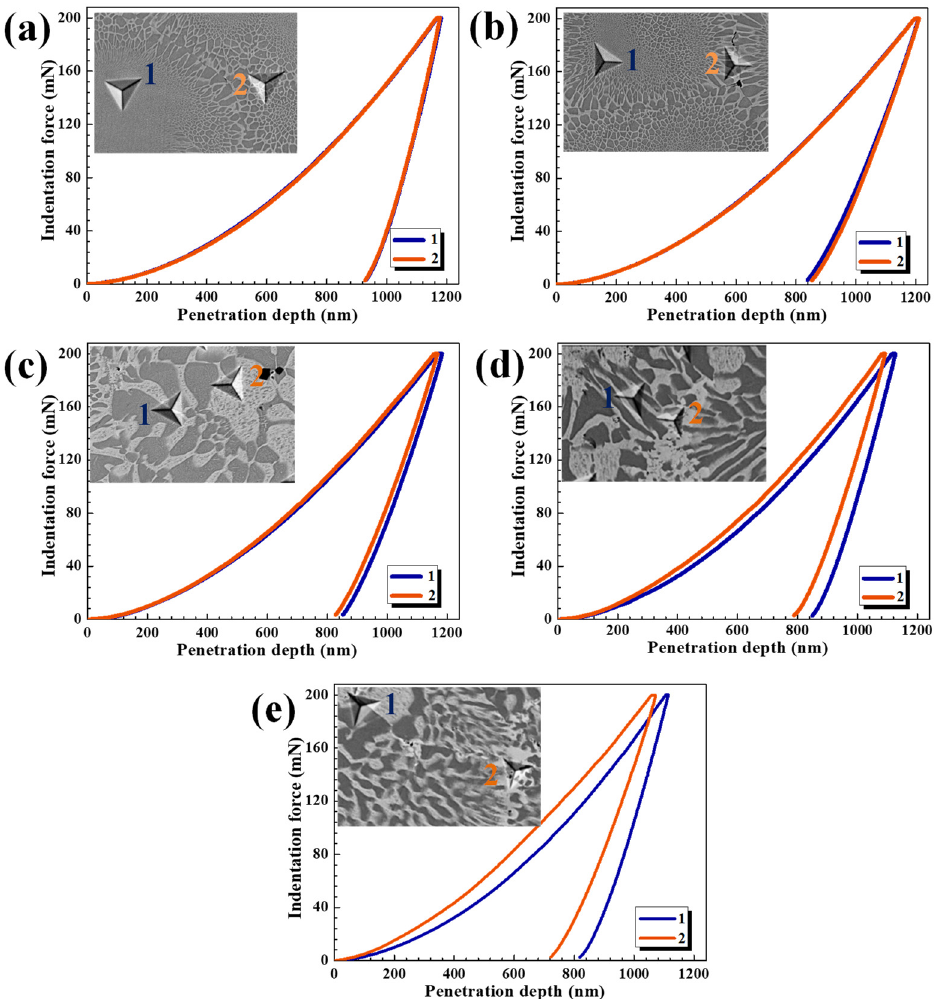
Figure 4. Representative indentation images and corresponding load-displacement curves for ( a ) AlCrFeNiTi 0.5 , ( b ) AlCrFeNiTi 0.5 Mo 0.1 , ( c ) AlCrFeNiTi 0.5 Mo 0.2 , ( d ) AlCrFeNiTi 0.5 Mo 0.3 , and ( e ) AlCrFeNiTi 0.5 Mo 0.4 samples. Table 2. Local micro-hardness and overall hardness of AlCrFeNiTi 0.5 Mo x HEAs.